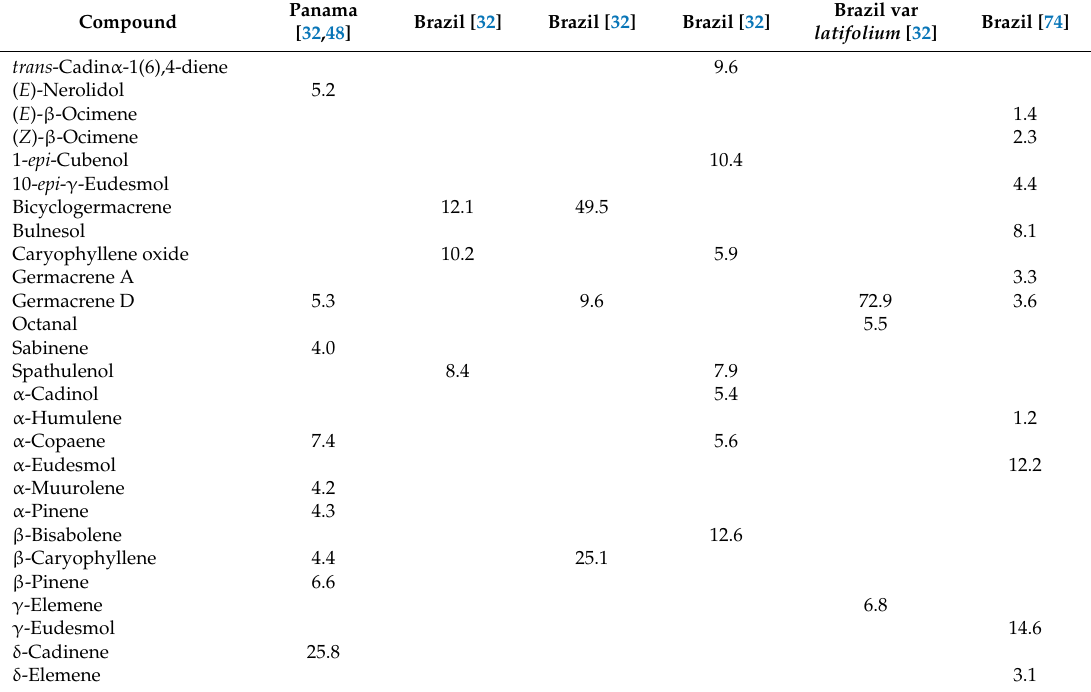
Table 14. Chemical compositions (%) of Piper arboreum Aubl. leaf essential